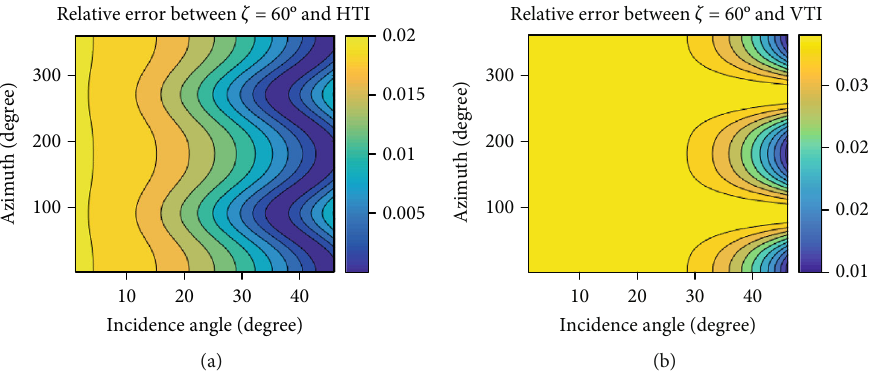
Figure 7: The relative error in azimuthally anisotropic EI if a TTI medium with dip of symmetry axis is modelled as an (a) HTI medium or a (b) VTI